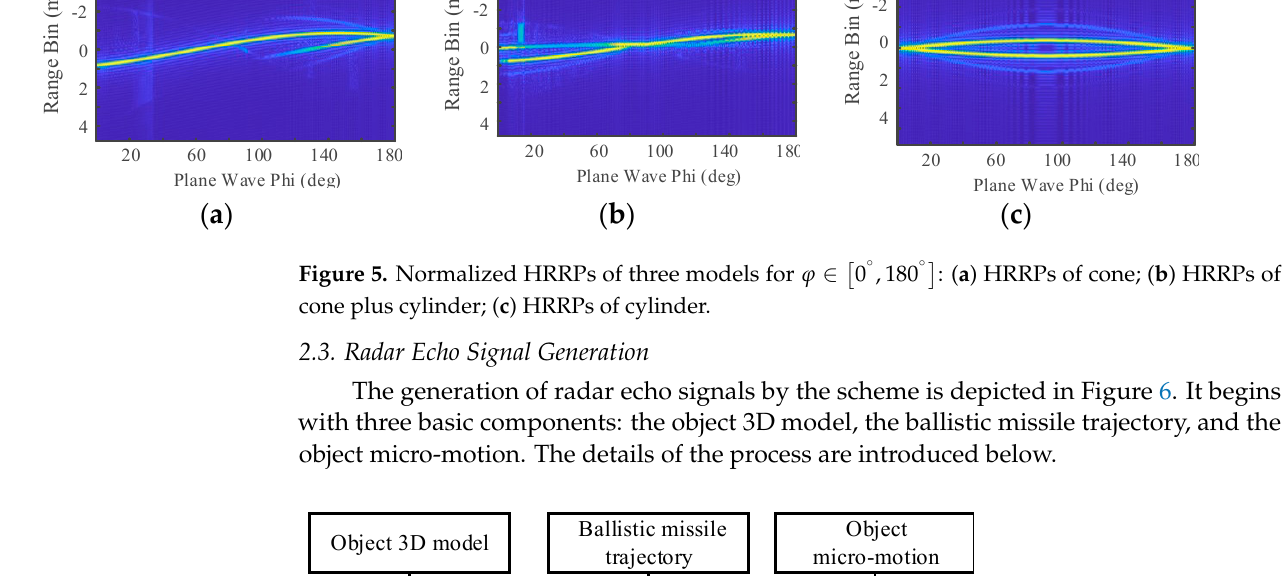
Table 2. Target micro-motion parameters .